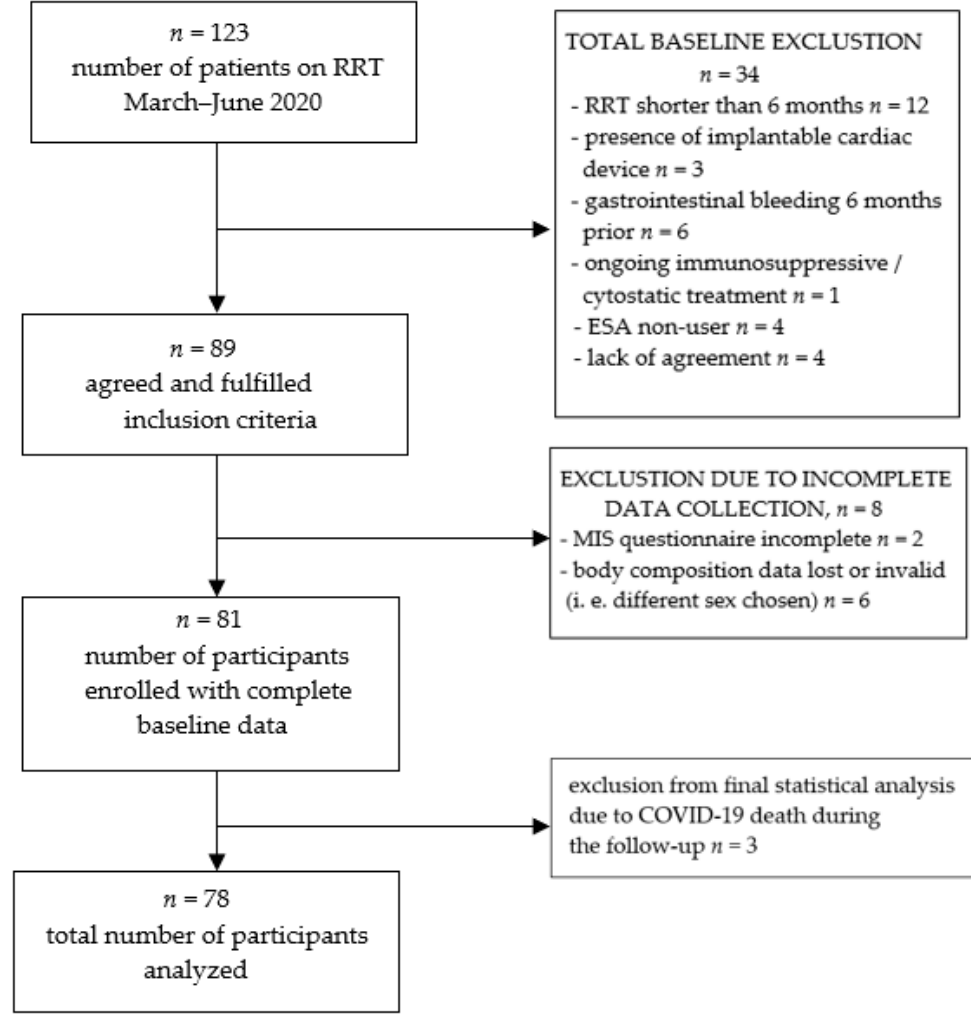
Figure 1. Study group